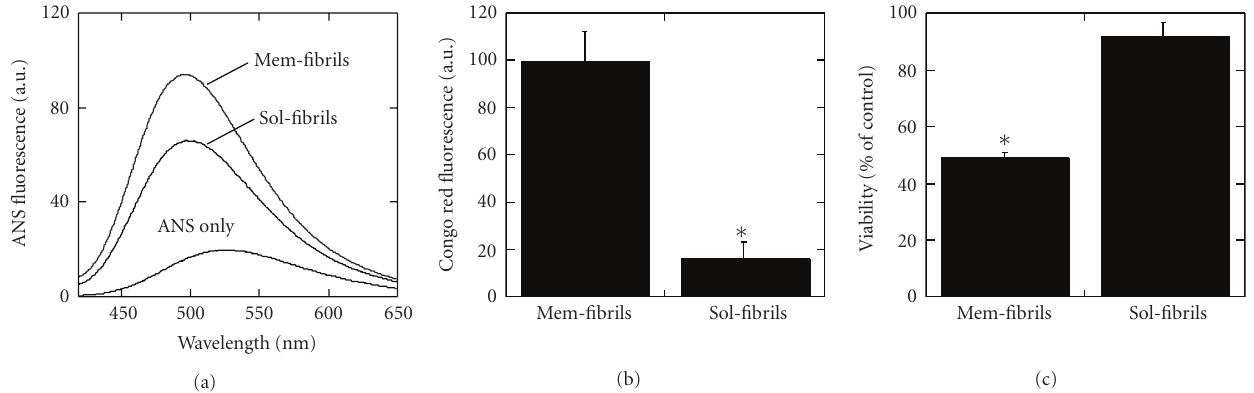
Figure 3: Comparison between Mem-fibrils and Sol-fibrils. Data taken from [20]. (a) Fluorescence spectra of ANS (5.0 μ M) in PBS were measured in the absence or presence of Mem-fibrils and Sol-fibrils of A β -(1–40) (2.5 μ M) with an excitation wavelength of 350 nm. The binding of the dye to a hydrophobic surface results in an enhancement in fluorescence intensity. (b) A β -(1–40) fibrils (25 μ M) were incubated with NGF-di ff erentiated PC12 cells for 30 min. Binding of A β -(1–40) fibrils to cells was evaluated by fluorescence intensity of Congo red per cell (mean ± S.E.; n ∼ 100, ∗ P < . 001). (c) A β -(1–40) fibrils (25 μ M) were incubated with NGF-di ff erentiated PC12 cells for 24 h. A β cytotoxicity was estimated with fluorescence intensity of the live cell marker calcein (mean ± S.E.; n = 6; ∗ P < . 001 against vehicle treatment).